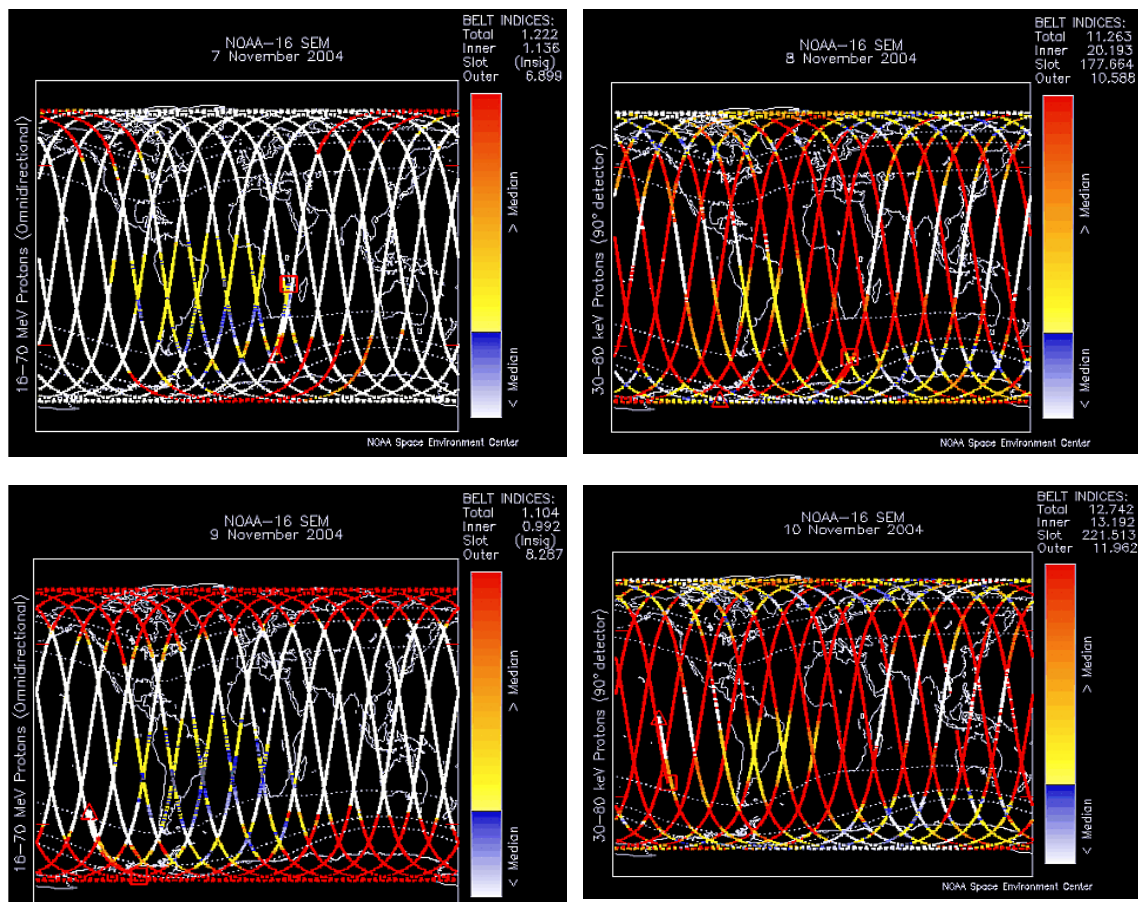
Fig. 22. Omni-directional 16-70 MeV protons recorded aboard the NOAA-16 spacecraft between 7-8 November, 2004 (top) and 9-10 November, 2004 (bottom).